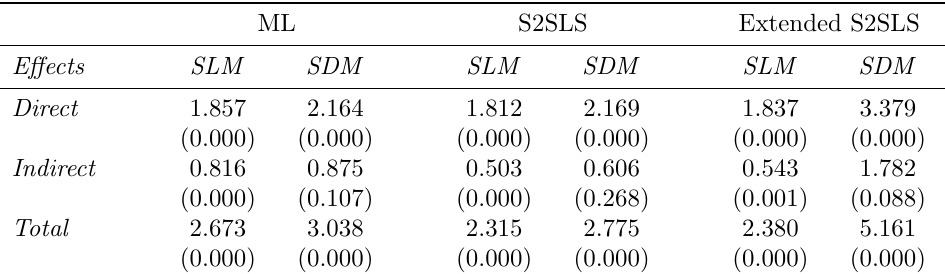
Table 3: Effects of PM 2 . 5 on ER visits due to respiratory